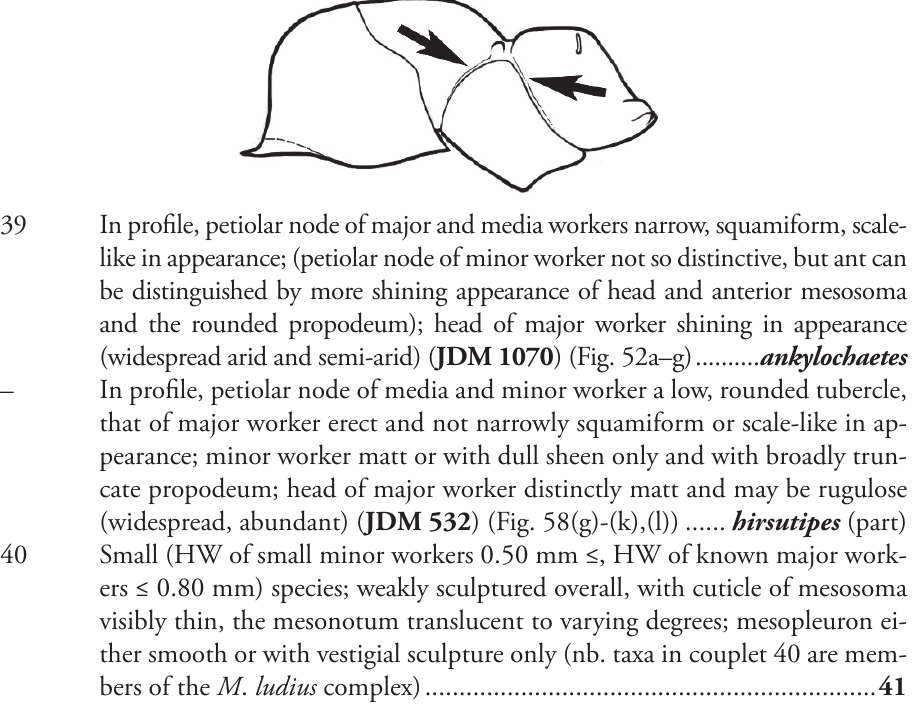
(widespread, abundant) ( JDM 532 ) (Fig. 58(g)-(k),(l)) ...... hirsutipes (part) 40 Small (HW of small minor workers 0.50 mm ≤, HW of known major work- ers ≤ 0.80 mm) species; weakly sculptured overall, with cuticle of mesosoma visibly thin, the mesonotum translucent to varying degrees; mesopleuron ei- ther smooth or with vestigial sculpture only (nb. taxa in couplet 40 are mem- bers of the M . ludius complex) ..................................................................